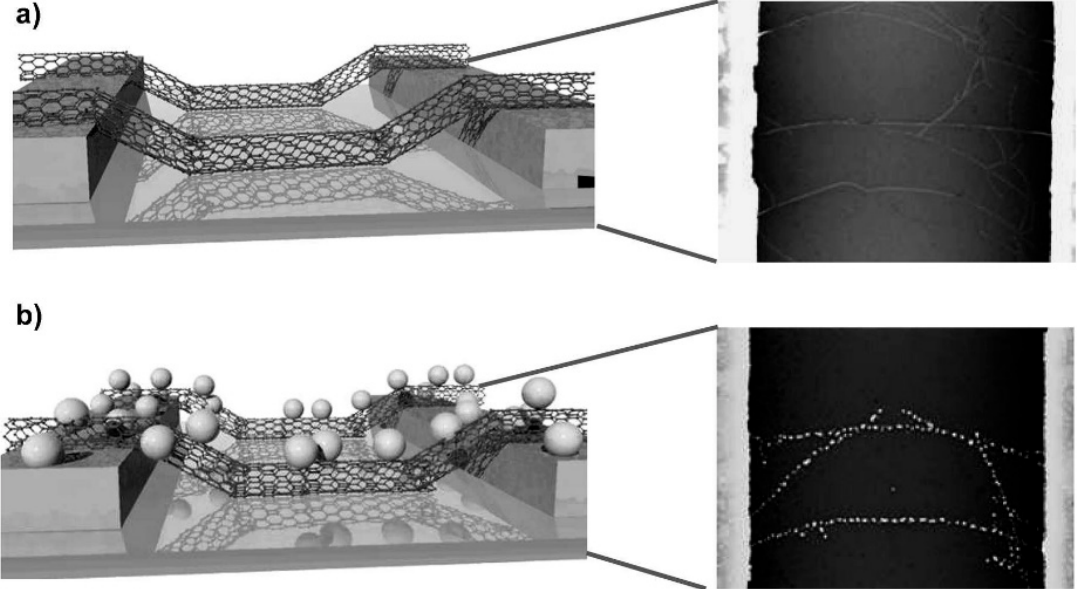
Figure 8. Schematic representation and SEM images of ( a ) carboxylated SWCNTs aligned between Au electrodes and ( b ) Au-decorated SWCNTs, as sensing films for gas sensors (FETs), for enhanced H 2 S sensing. Au NPs play a crucial role in device-performance by modulating the mobility after the gaseous-molecule interactions. Reprinted with permission from Ref. [156]. Copyright © 2011 Wiley-VCH Verlag GmbH & Co. KgaA, Weinheim.